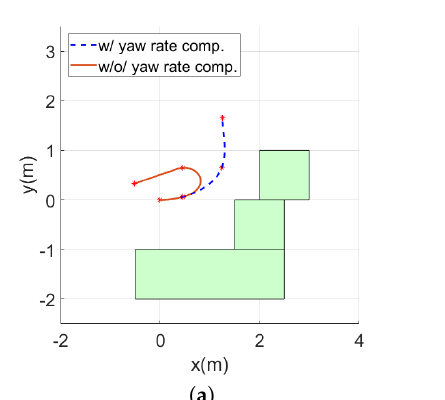
Figure 12. Trajectories of the MAVand the time history of the sum of the EOF when the MAV moves with a constant speed: ( a ) trajectories of the MAV; and ( b ) time history of the sum of the